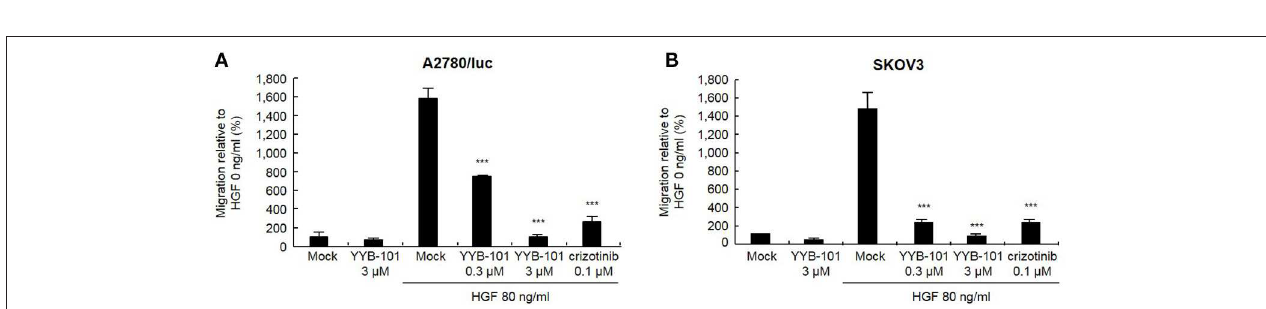
FIGURE 2 | Effect of YYB-101 on migration of ovarian cancer cells. (A) A2780/luc (3 × 10 5 ) and (B) SKOV3 (1 × 10 5 ) cells were seeded in upper chambers. Lower chambers contained 3 µ M YYB-101, 80ng/mL Hepatocyte growth factor (HGF), 80ng/mL HGF plus 0.3 µ M or 3 µ M YYB-101, or 80ng/mL HGF plus 0.1 µ M crizotinib. After culture for 48 or 8h (A2780/luc or SKOV3 cells, respectively), migrated cells were observed using light microscopy. *** p < 0.001 vs. control, one-way ANOVA, followed by Tukey’s multiple comparison test.